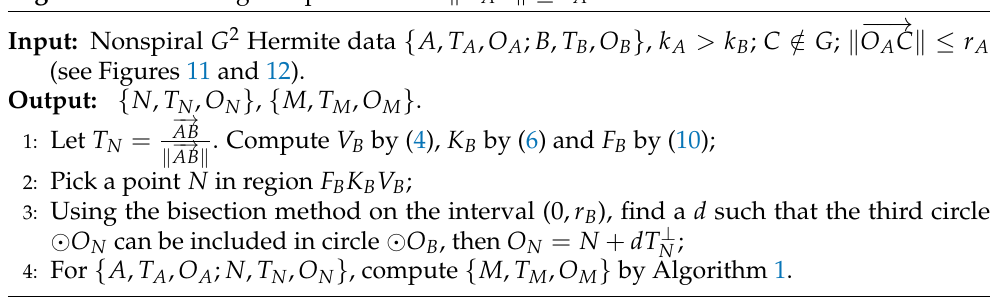
Algorithm 4 Inserting two points when